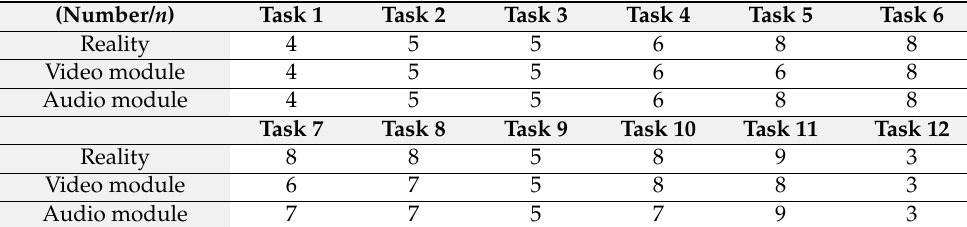
Table 6. Number of action